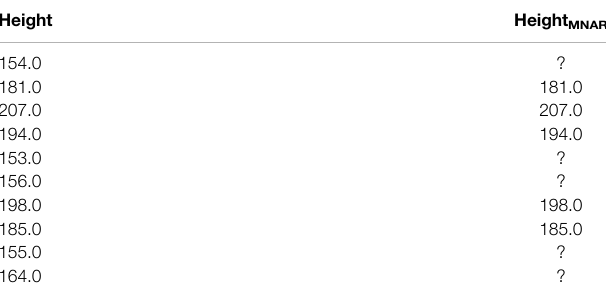
TABLE 4 | In the MNAR condition, height values are discarded dependent on the actual height values. All discarded values correspond to small height